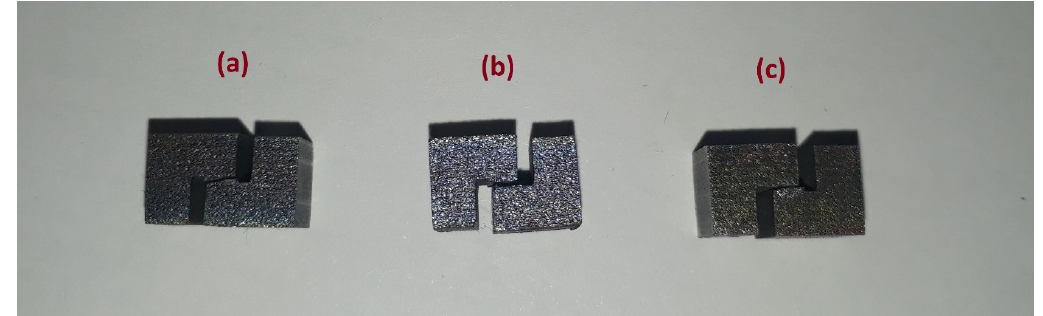
Figure 11. Failure of the NSSS sample under ( a ) quasi-static loading with strain rates of ( b ) 900 s − 1 and ( c ) 3000 s − 1 .